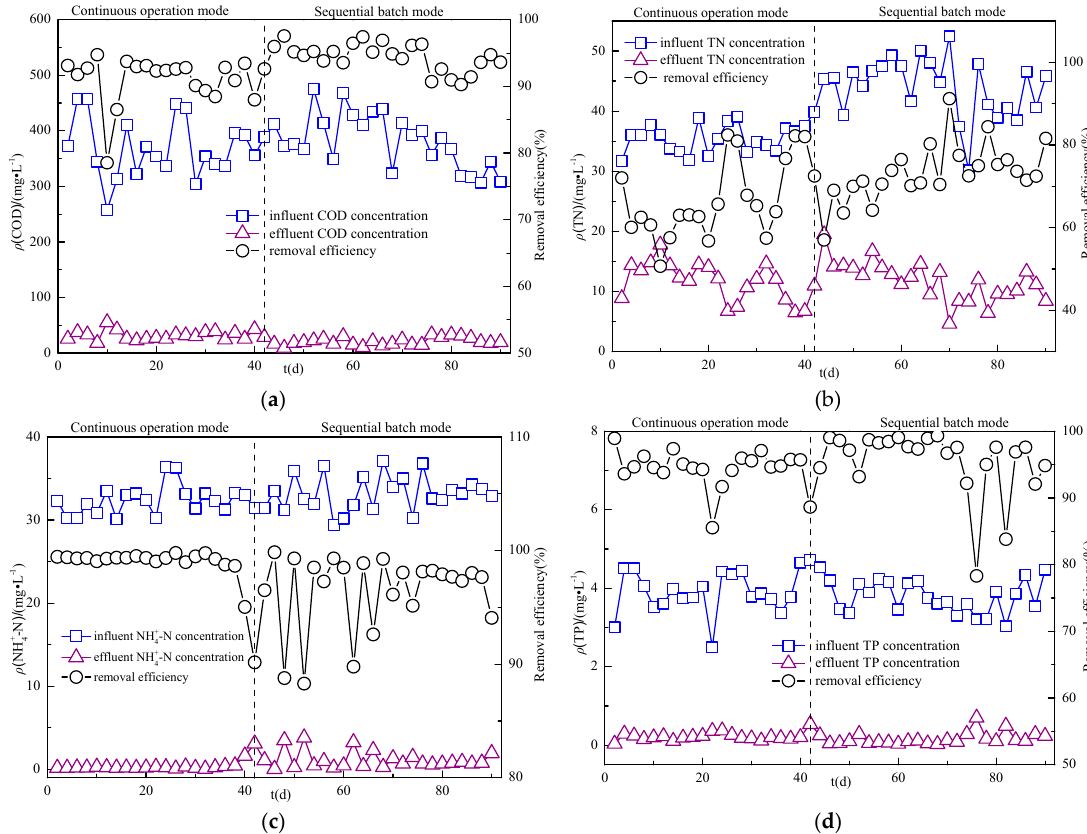
Figure 7. Pollutants removal effect of MPSR in two operating modes. ( a ) COD, ( b ) TN, ( c ) NH 4+ -N, ( d ) TP.